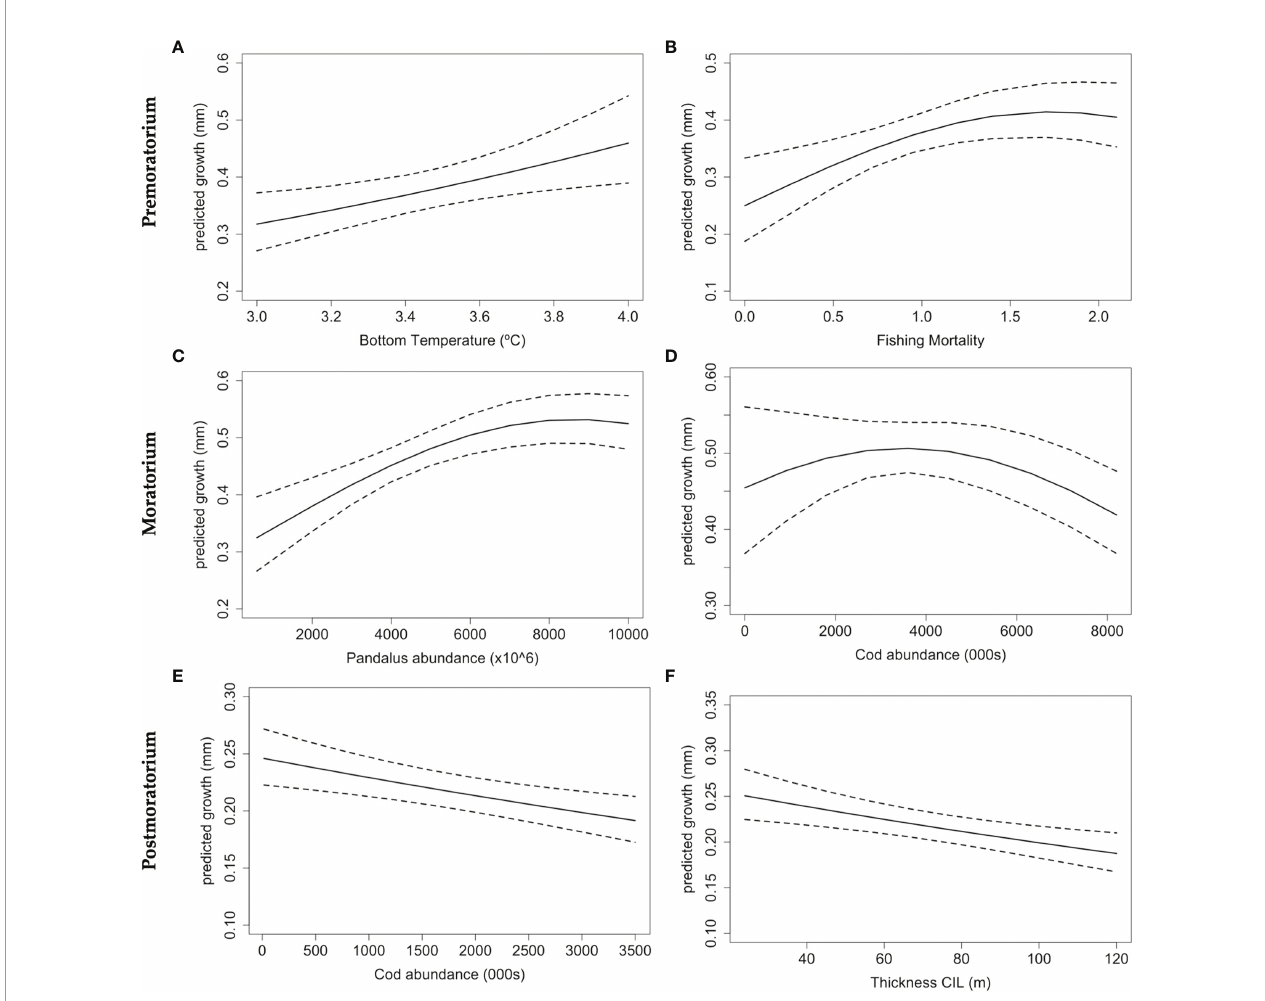
FIGURE 6 | Predicted effects of extrinsic variables on Atlantic cod growth of the Flemish cap during 3 periods: Premoratorium (1988-1998), Moratorium (1999- 2009) and Postmoratorium (2010-2019), using the Master chronology (i.e. all pooled ages). Panels indicates: Postmoratorium effects: Sea Bottom Temperature (A) and Fishing mortality (B) ; Moratorium effects: Pandalus abundance (C) and Cod abundance (D) ; and Postmoratorium effects: Cod abundance (E) , and Thickness of the cold intermediate layer (CIL) (F) . Dashed lines represent 95% Con fi dence